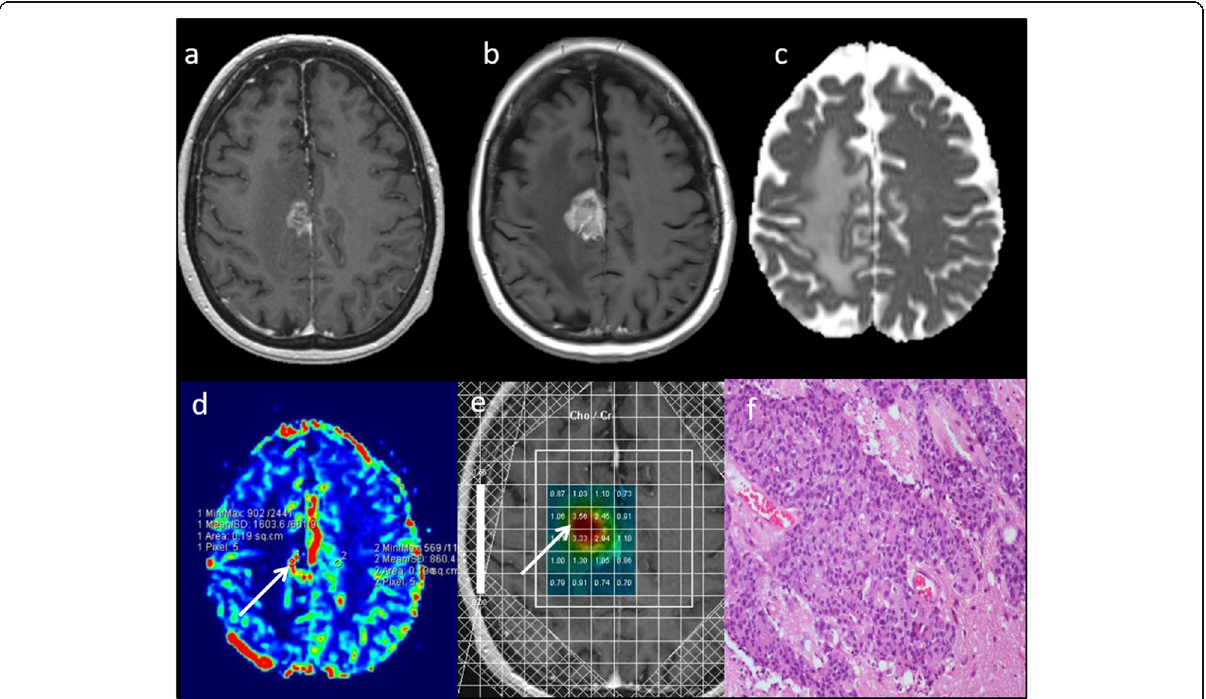
Fig. 11 Brain metastasis — recurrent tumour. Brain metastasis from primary breast carcinoma. a Brain metastasis in the right mesial frontal lobe motor area on axial T1-weighted post-contrast MRI. b Post-SRS scan at 29 weeks demonstrates increase in the lesion size with oedema. Multiparametric MRI demonstrates: ( c ) a borderline ADC (999 × 10 − 6 mm 2 /s), ( d ) a borderline rCBV ratio (1.9, arrow) on PWI and ( e ) highest Cho/ Cr ratio of 3.6 (arrow) on multi-voxel MRS (TE = 30 ms). Two of the three parameters (DWI and MRS) suggest poor response and disease progression. f Surgical decision was taken to operate on the motor cortex and excision of right frontal tumour was performed. Histopathology demonstrates poorly differentiated metastatic adenocarcinoma with discernible focal ductal structures and tumour well demarcated from adjacent brain